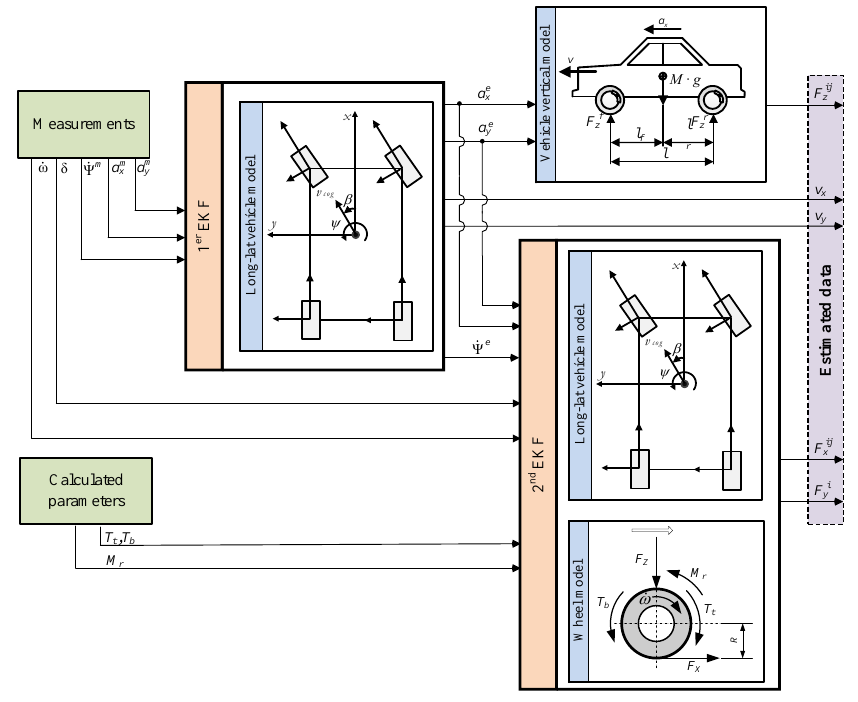
Figure 4. Estimation algorithm scheme.